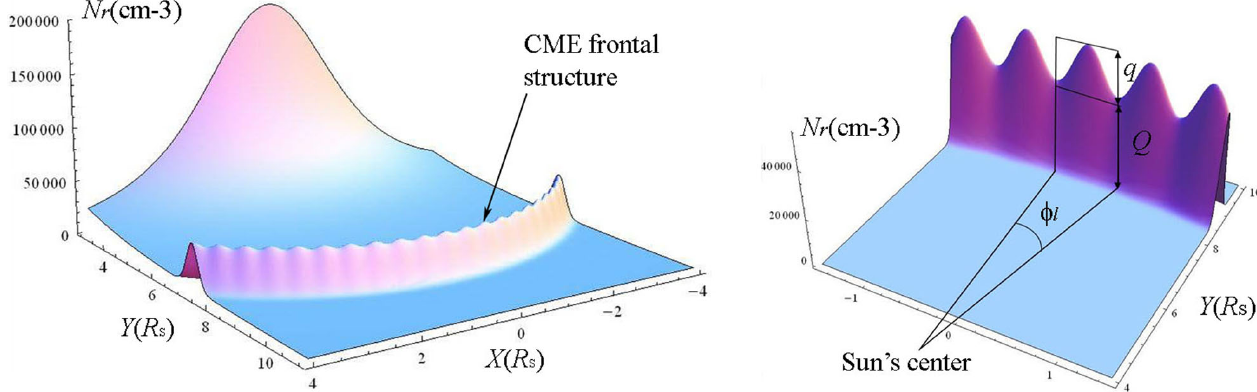
Fig. 3. Left panel: The regular electron density distribution N e (r) in the near-solar plasma. Right panel: Density variation parameters, ϕ l and δ = q/Q in the CME front.